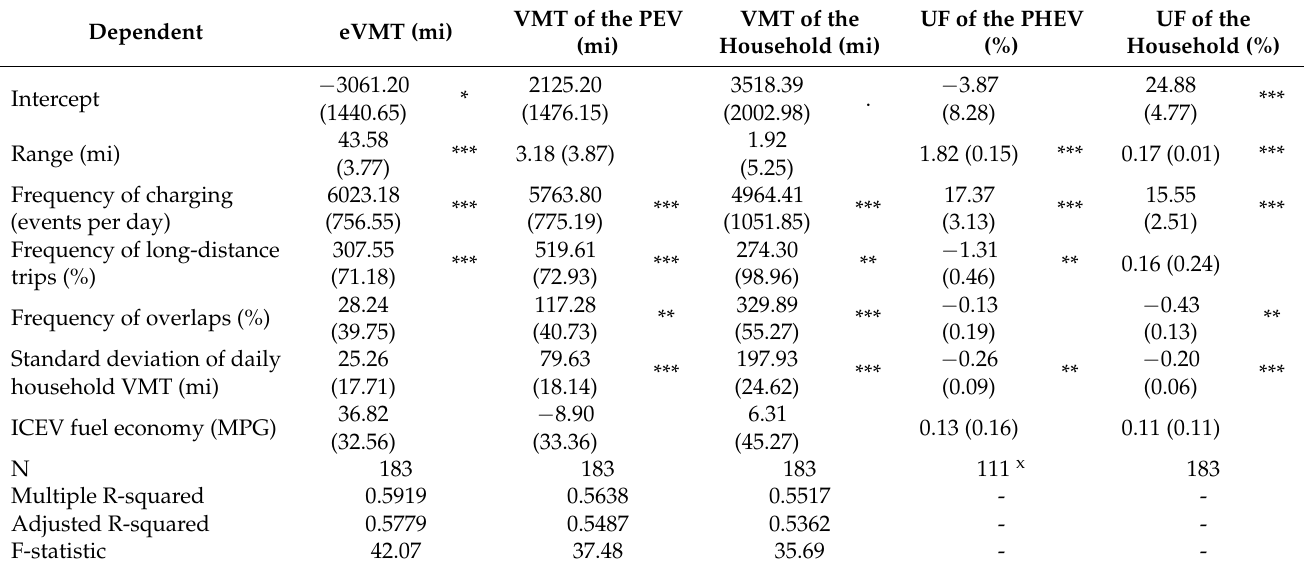
Table 3. Regression results for how household factors impact vehicle miles and electrification in two-car